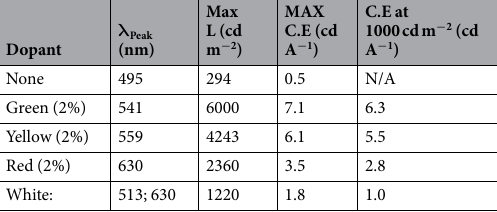
Table 1. Electrical properties from different